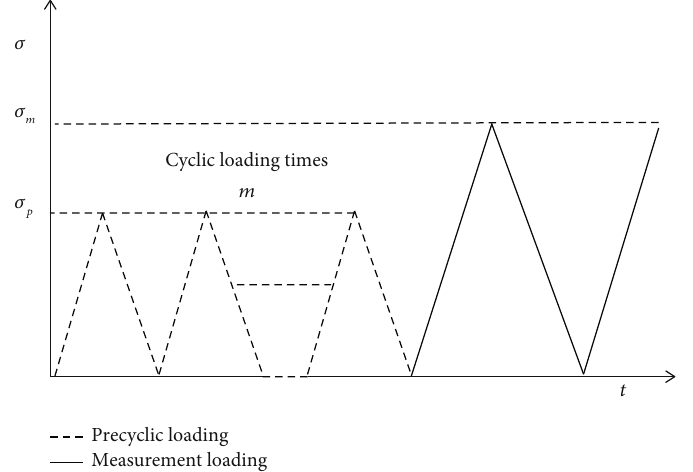
Figure 5: Loading system.